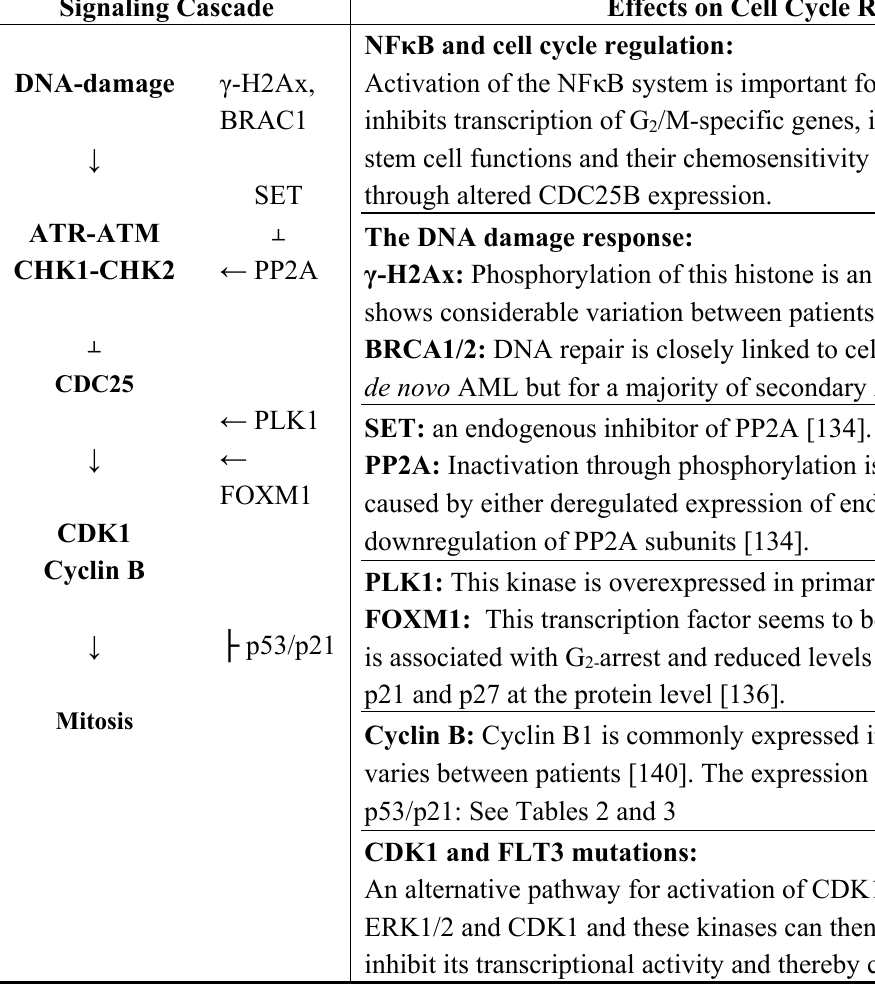
Table 4. The molecular environment of CDC25 ‒ altered regulation of the G 2 checkpoint in human AML ( ← stimulation; ┴ inhibition). Signaling